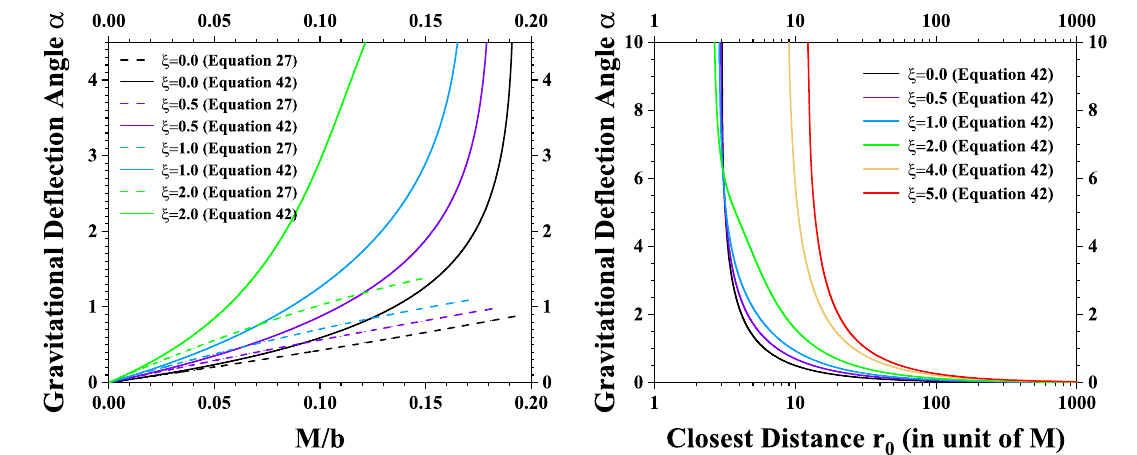
Fig. 3 The gravitational deflection angles for acoustic Schwarzschild black hole obtained by solving the trajectories of null geodesics. We have chosen the cases ξ = 0, ξ = 0 . 5, ξ = 1, ξ = 2, ξ = 4 and ξ = 5 as representative examples. In the left panel, the gravitational deflection angles are plotted in region 0 ≤ M / b ≤ 0 . 2. Comparative results of deflection angles obtained using Gauss–Bonnet theorem in